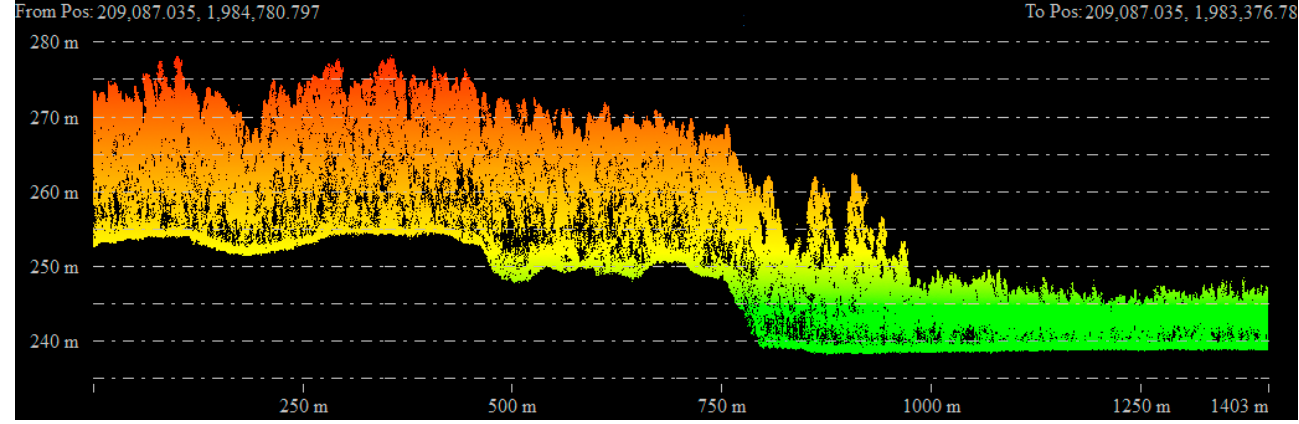
Figure 2. Lidar point cloud showing the differences in vegetation heights, 1400 m long profile. Lidar returns that occurred within each of the 73 transects (21 lowland, 27 transition, 24 upland, and 1 wetland) were extracted to create a point cloud for each transect. A digital elevation model, DEM, was created using preassigned ground points, in which the raster pixels represent bare-earth elevations above sea level. For normalizing, the ground surface elevation obtained from the DEM was subtracted from all returns to convert from altitude to height. After normalizing the lidar data, a digital surface model, DSM, and a canopy height model, CHM, raster layers with 1 m resolution were created using FUSION. The workflow of the satellite and lidar data processing used in this study is shown in Figure 3.